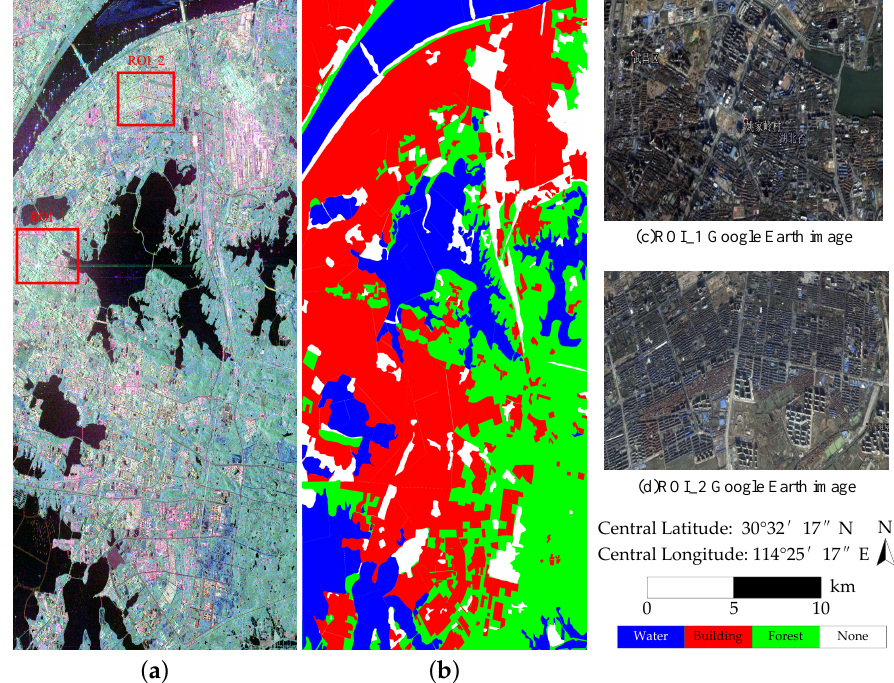
Figure 8. RS-2 Wuhan dataset and the ground truth map. ( a ) Pauli pseudo-color image of RS-2 Wuhan; ( b ) Ground truth map of RS-2 Wuhan; ( c ) The optical image of ROI_1; ( d ) The optical image of